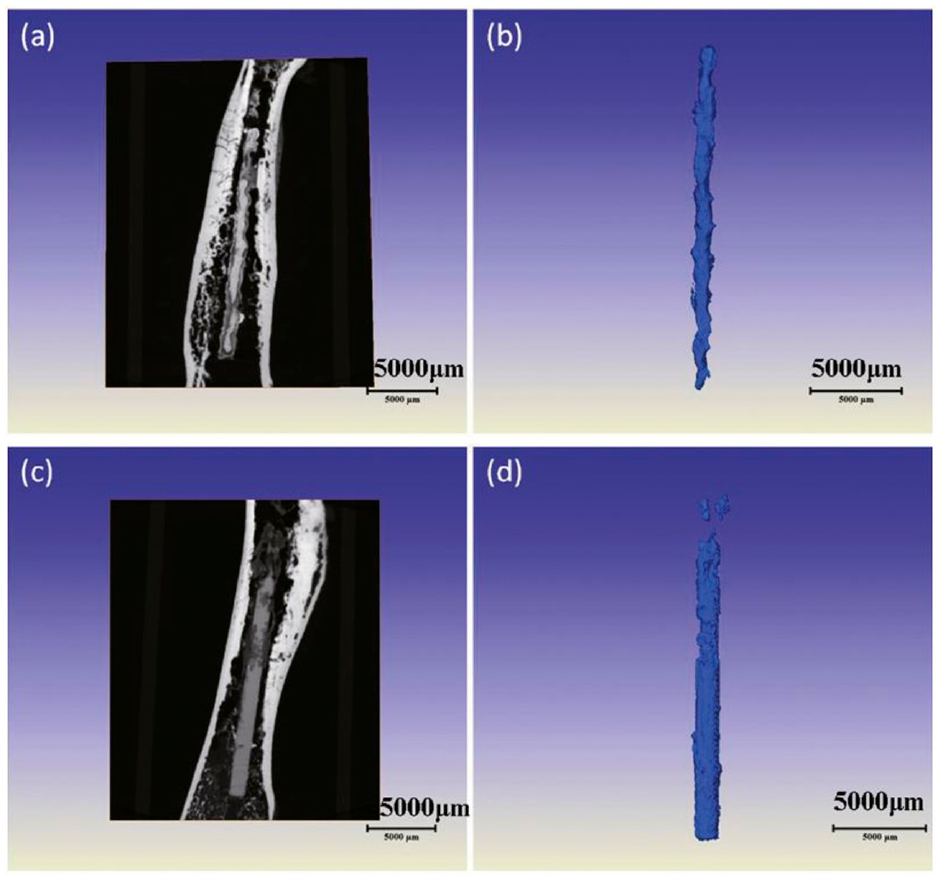
Figure 8. 2D slices and 3D volume renderings of ( a , b ) Mg–Sr alloy and ( c , d ) Mg–Sr alloy with Sr–CaP coating visualized in vivo using the XRT technique after implantation of 8 weeks in rabbit femur [129].